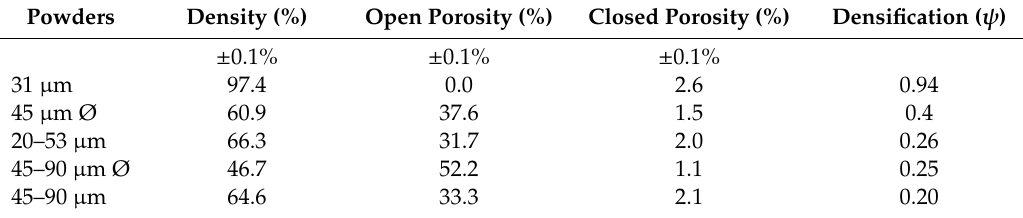
Table 7. Pore characteristics of samples sintered at 1395 ◦ C for 90 min